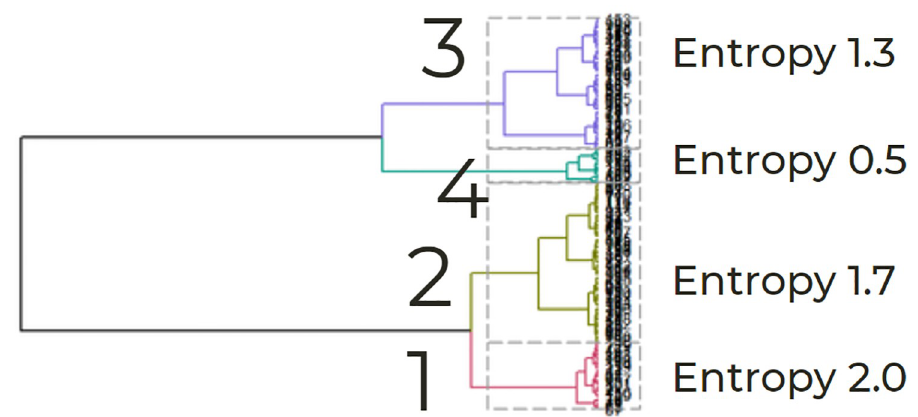
Fig 7. Phenotypes: Four clusters. Allowing for one additional split in Hierarchical Ward’s clustering identified four phenotypes. Phenotype 1, the highest entropy phenotype, characterized the admissions with the worst outcomes (phenotype 1 in this split contains 28 of the original 95 admissions of phenotype 1 based on a two-group cluster).